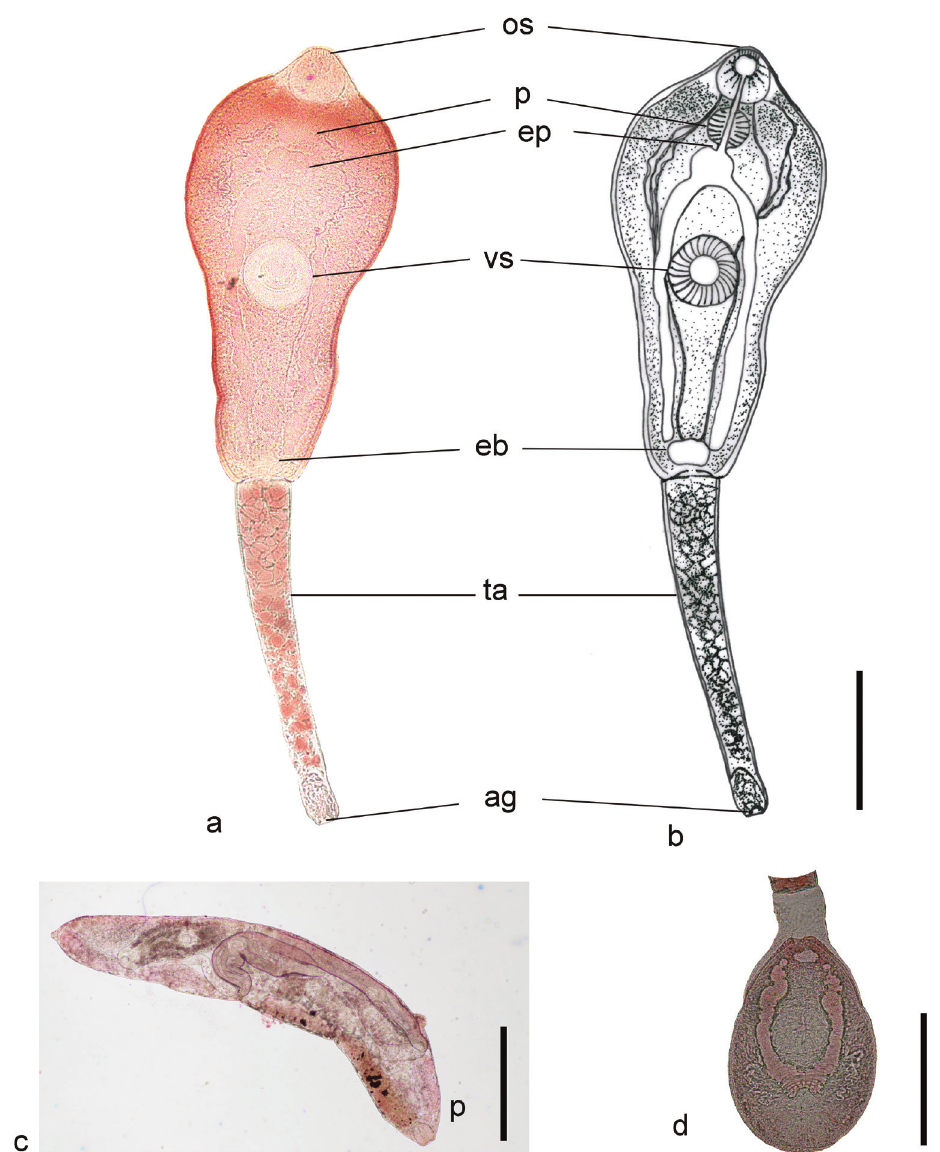
Figure 12. Philophthalmus gralli Mathis & Léger, 1910 a . specimen stained with 0.5% neutral red. b . drawing of cercaria. c . redia stained with 0.5% neutral red. d . metacercaria stained with 0.5% neutral red. Abbreviations – ag: adhesive gland; eb: excretory bladder; ep: esophagus; os: oral sucker; p: pharynx; ta: tail; vs: ventral sucker. Scale bars: 50